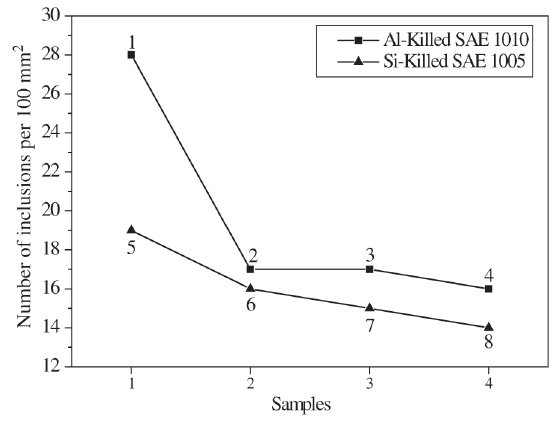
Figure 3. Variation of the number of inclusions per 100 mm 2 of area in the samples of the SAE 1010 and 1005 steels.